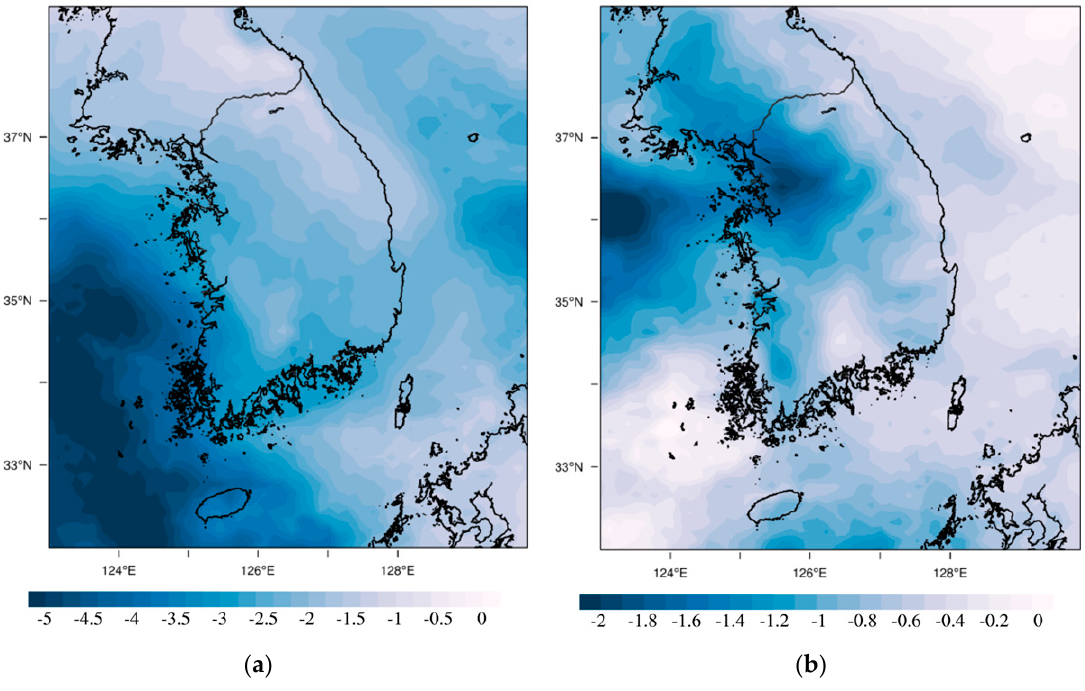
Figure 3. Changes of SO 42 − and PM 2.5 concentrations ( μ g m − 3 ) in South Korea due to the reduction of overseas SO 2 emissions ((R_FSO2)–simulations that applied basic emissions (BASE)). ( a ) SO 42 − , ( b ) PM 2.5 .